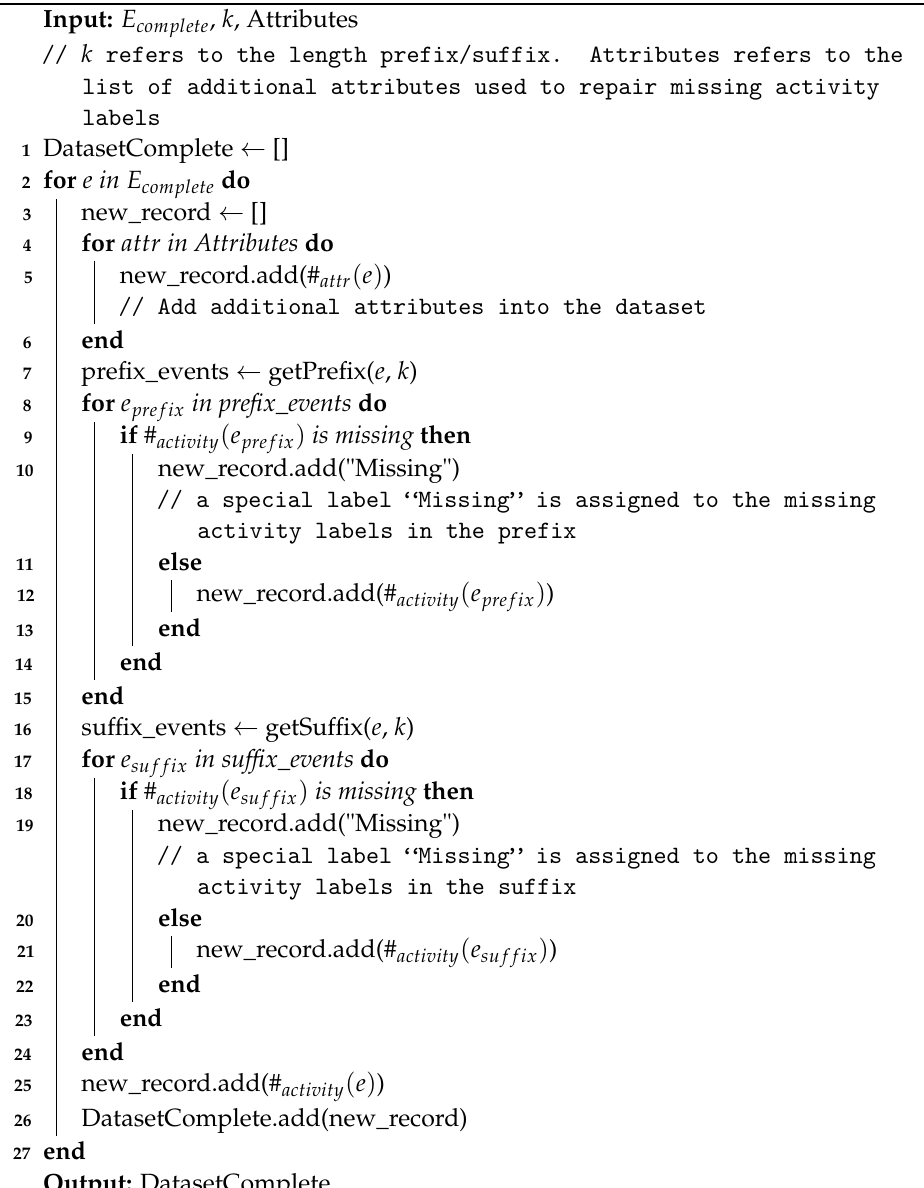
Algorithm 1: Constructing the Training Dataset from E